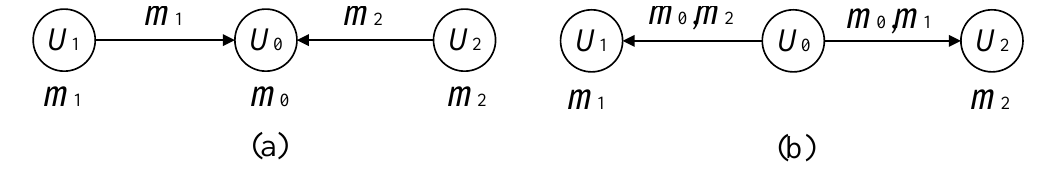
Figure 1. The two-way relay channel with a common message. ( a ) The users transmit to the relay in turn; ( b ) The relay broadcasts to the